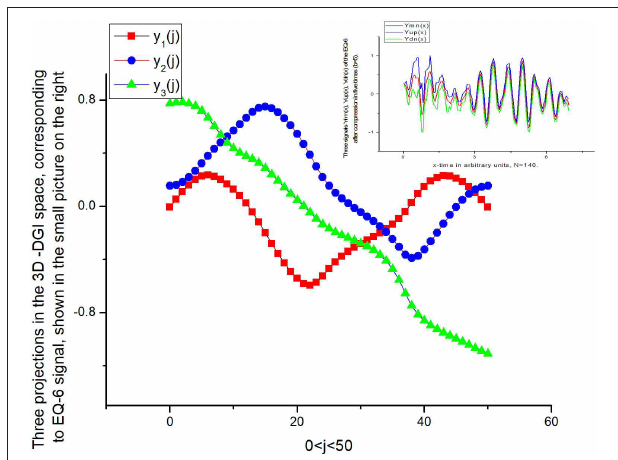
FIGURE 15 | The behavior of these projections y 1,2,3 ( j ) corresponding to EQ-6 are, in spite of their differences in amplitudes, similar to EQs-1,3,4. Therefore, this analysis of the different EQs enables them to be classified as similar or different.